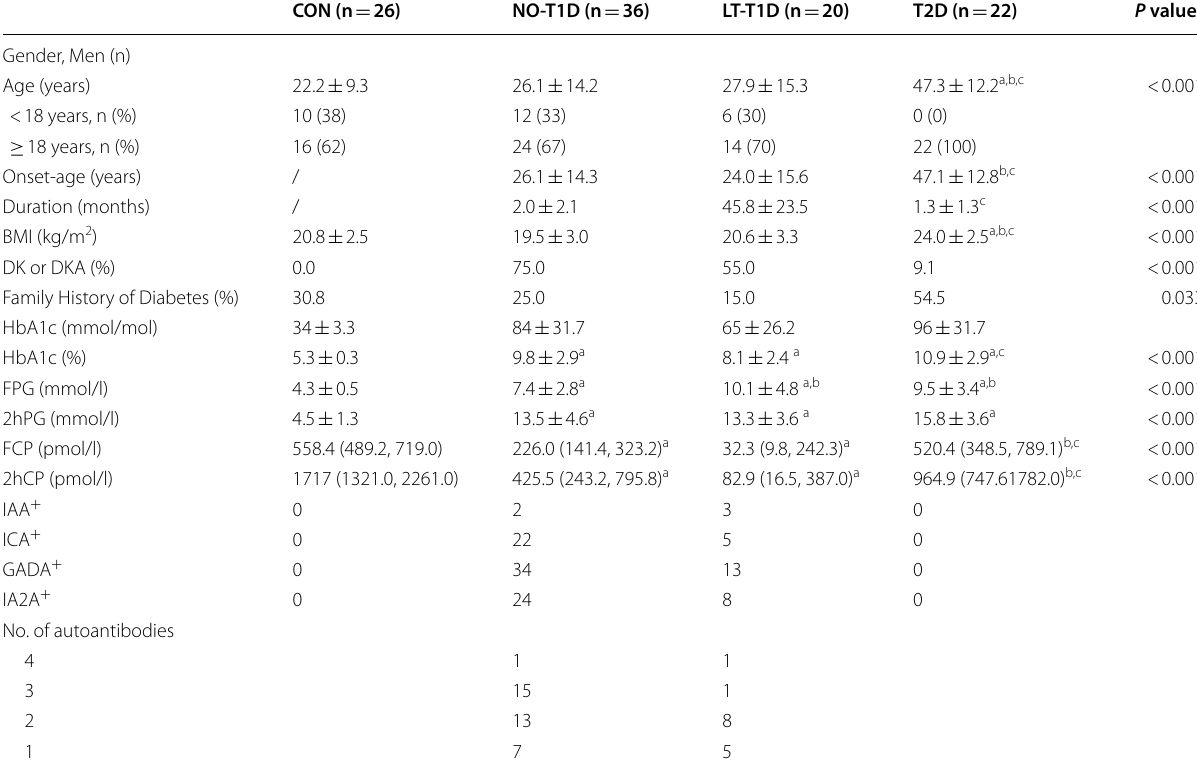
Data are n, %, mean SD, and median (25th–75th percentile). /, not appropriate. a P < 0.05 vs CON; b P < 0.05 vs NO-T1D; c P < 0.05 vs LT-T1D; NO-T1D, new-onset T1D; ± LT-T1D, long-term T1D; T2D, type 2 diabetes; FPG, fasting plasma glucose; 2hPG, 2 h postprandial plasma glucose; FCP, fasting C-peptide; 2hCP, 2-h